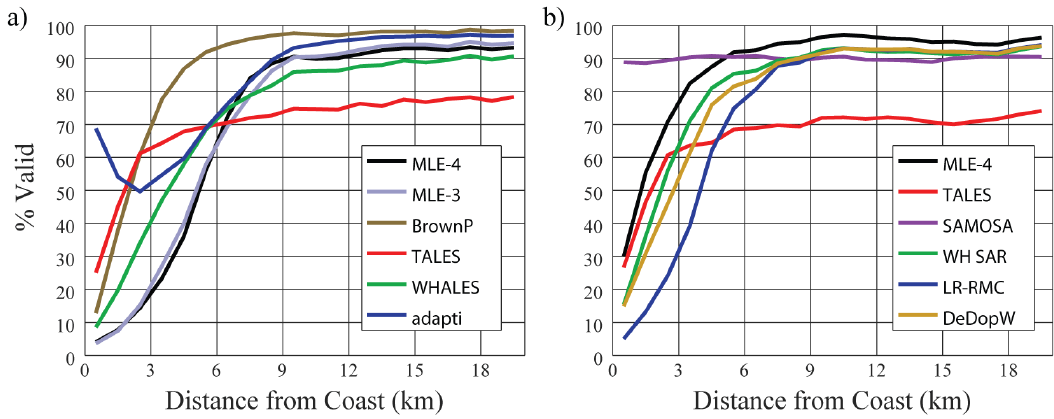
Figure 2. Data return rates for various retrackers as the altimeters approach the coast. Plots show percentage flagged as acceptable estimate for ( a ) Jason-3 and ( b ) Sentinel-3A. The data here are ”quasi-global” i.e., from the two years of selected tracks used for the Round Robin, but avoiding areas of sea-ice, and are binned at intervals of 1